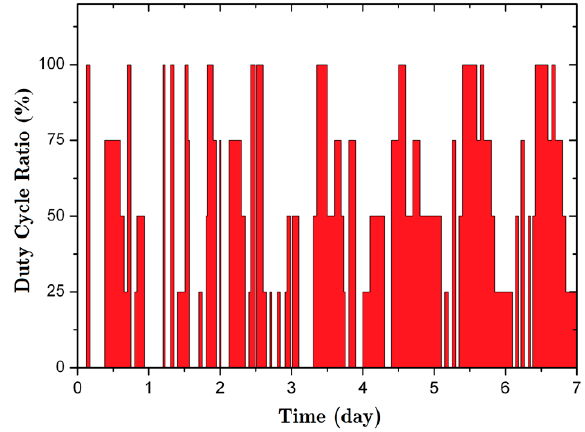
Figure 12. Changes of duty cycle ratio (with 20% initial electricity).